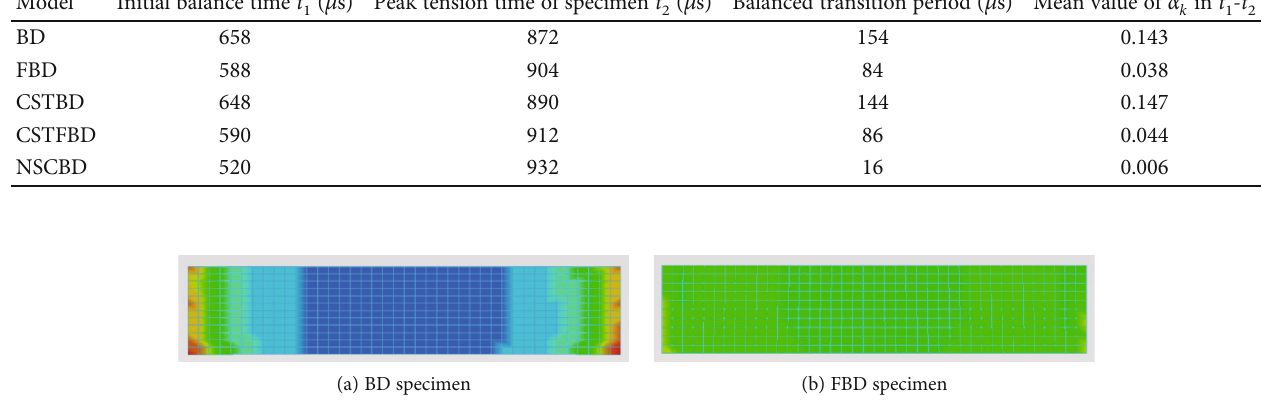
Table 3: Results of stress balance analysis of fi ve con fi gurations of disc specimens. Model